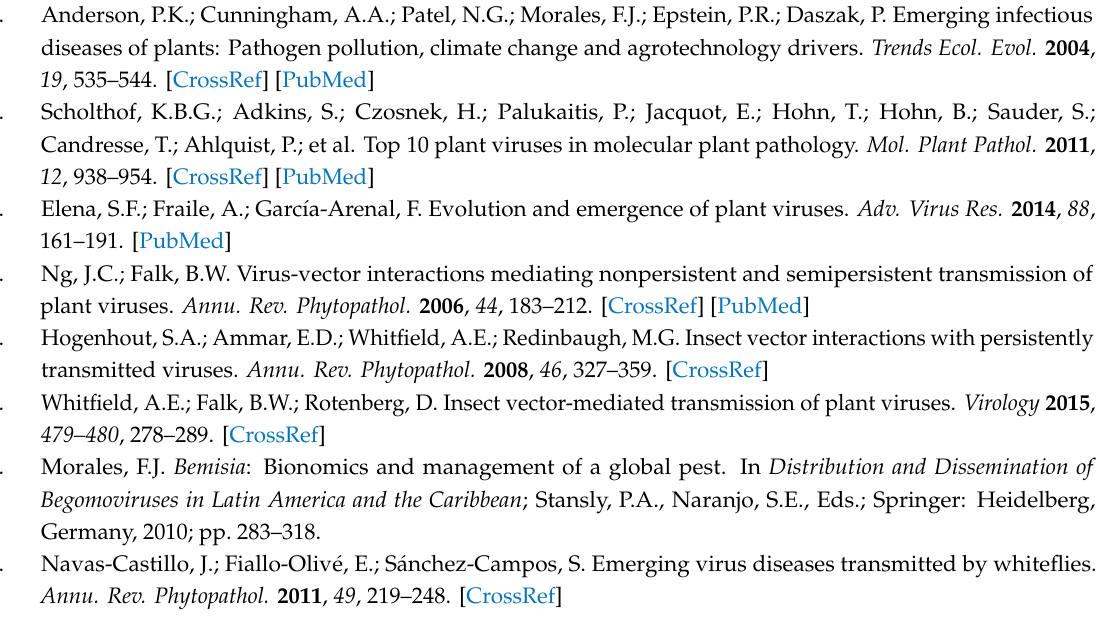
Figure S1: Pearson correlation coe ffi cient of gene expression levels among 15 samples, Figure S2: Common DEGs in virus-infected whiteflies, ( A ) Venn-diagram showing unique and common DEGs in di ff erent comparisons. ( B ) Hierarchical cluster analysis of 235 identified common DEGs, Figure S3: Time-associated gene clusters. ( A ) Hierarchical cluster of 127 up-regulated genes. ( B ) Hierarchical cluster of 355 down-regulated genes, Table S1: Summary of RNA-Seq datasets generated from whiteflies fed on TYLCV-infected tomato plants for 0, 2, 6, 12 and 48 h, Table S2: Common DEGs involved in signal transduction in virus-infected